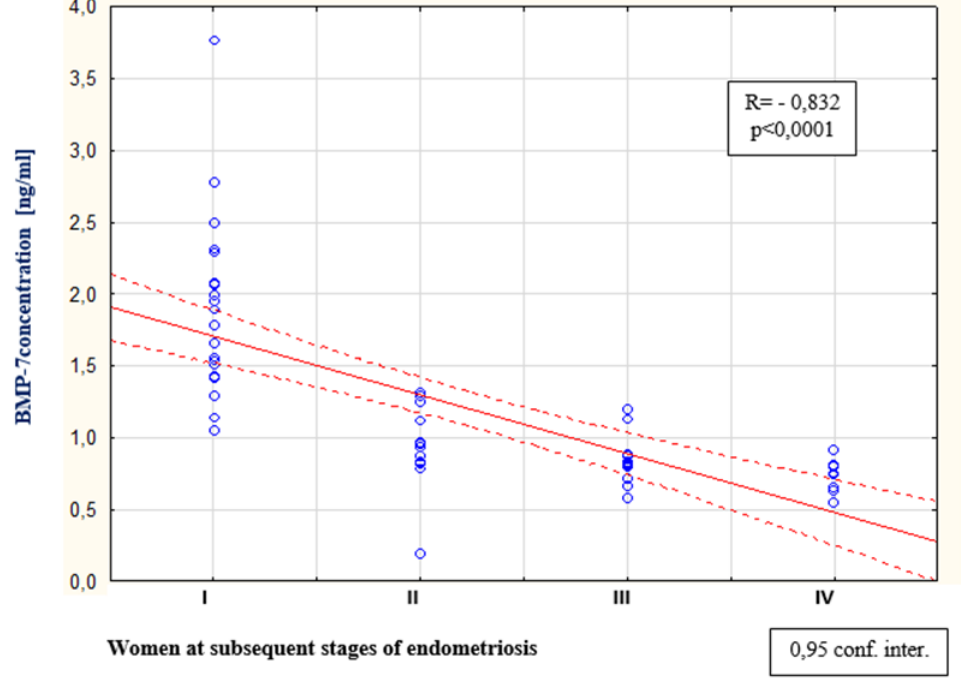
Figure 5. Linear regression curve illustrating the correlation between the concentration of BMP-7 in the peritoneal fluid of women with endometriosis and the subsequent stages of the disease.